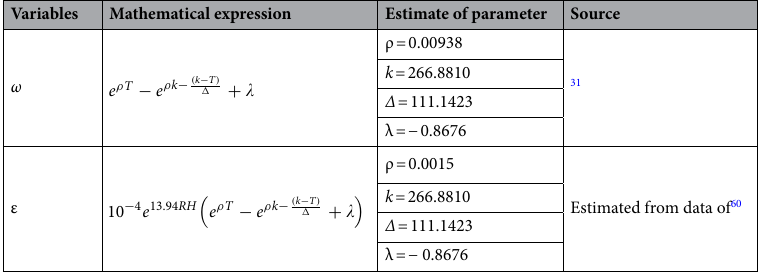
Table 3. Expression of ε and ω as a function of temperature and relative humidity. ω ( T ) is the daily fungal growth rate at temperature T , ε( T , RH ) is the proportion of fungal growth media (pest insects) allocated towards CFU (mycelium/conidia) (per day) at temperature T and relative humidity , ρ describes the acceleration rate of the lethal time from the low to optimal temperature; k represents the thermal maximum threshold, Δ describes the temperature range over which thermal breakdown becomes an over-riding influence; λ is the asymptote to which the function tends at the thermal minimum threshold 31